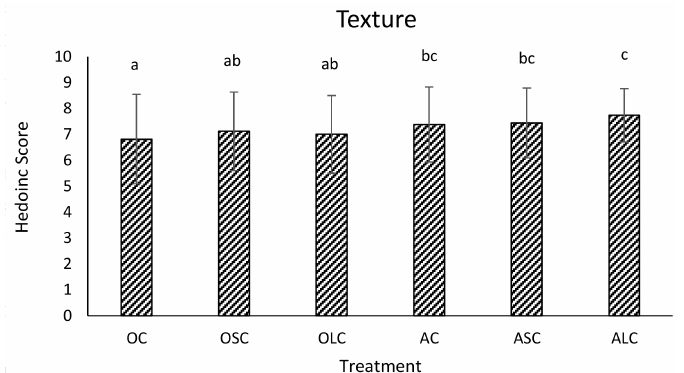
Figure 5. The hedonic scores (Mean ± SD) on the texture of all six fruit juice samples from the panellists. The same letter above each bar graph indicates that there was no significant difference ( p > 0.05), while bar graphs with different letters indicate that there was a significant difference ( p < 0.05) according to Tukey’s studentized range test. OC, OSC, OLC (orange juice control, short chain and long chain inulin